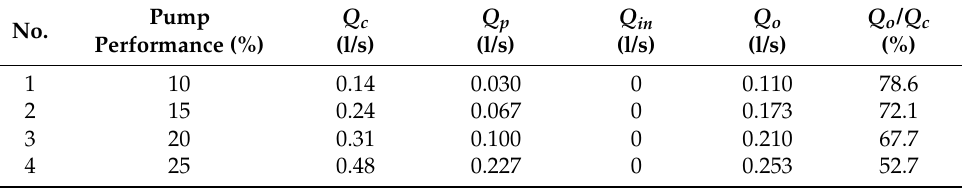
Table 9. Pilot test on the HJ-3 extraction well on 2 July 2020 (measured profile 15.75 m